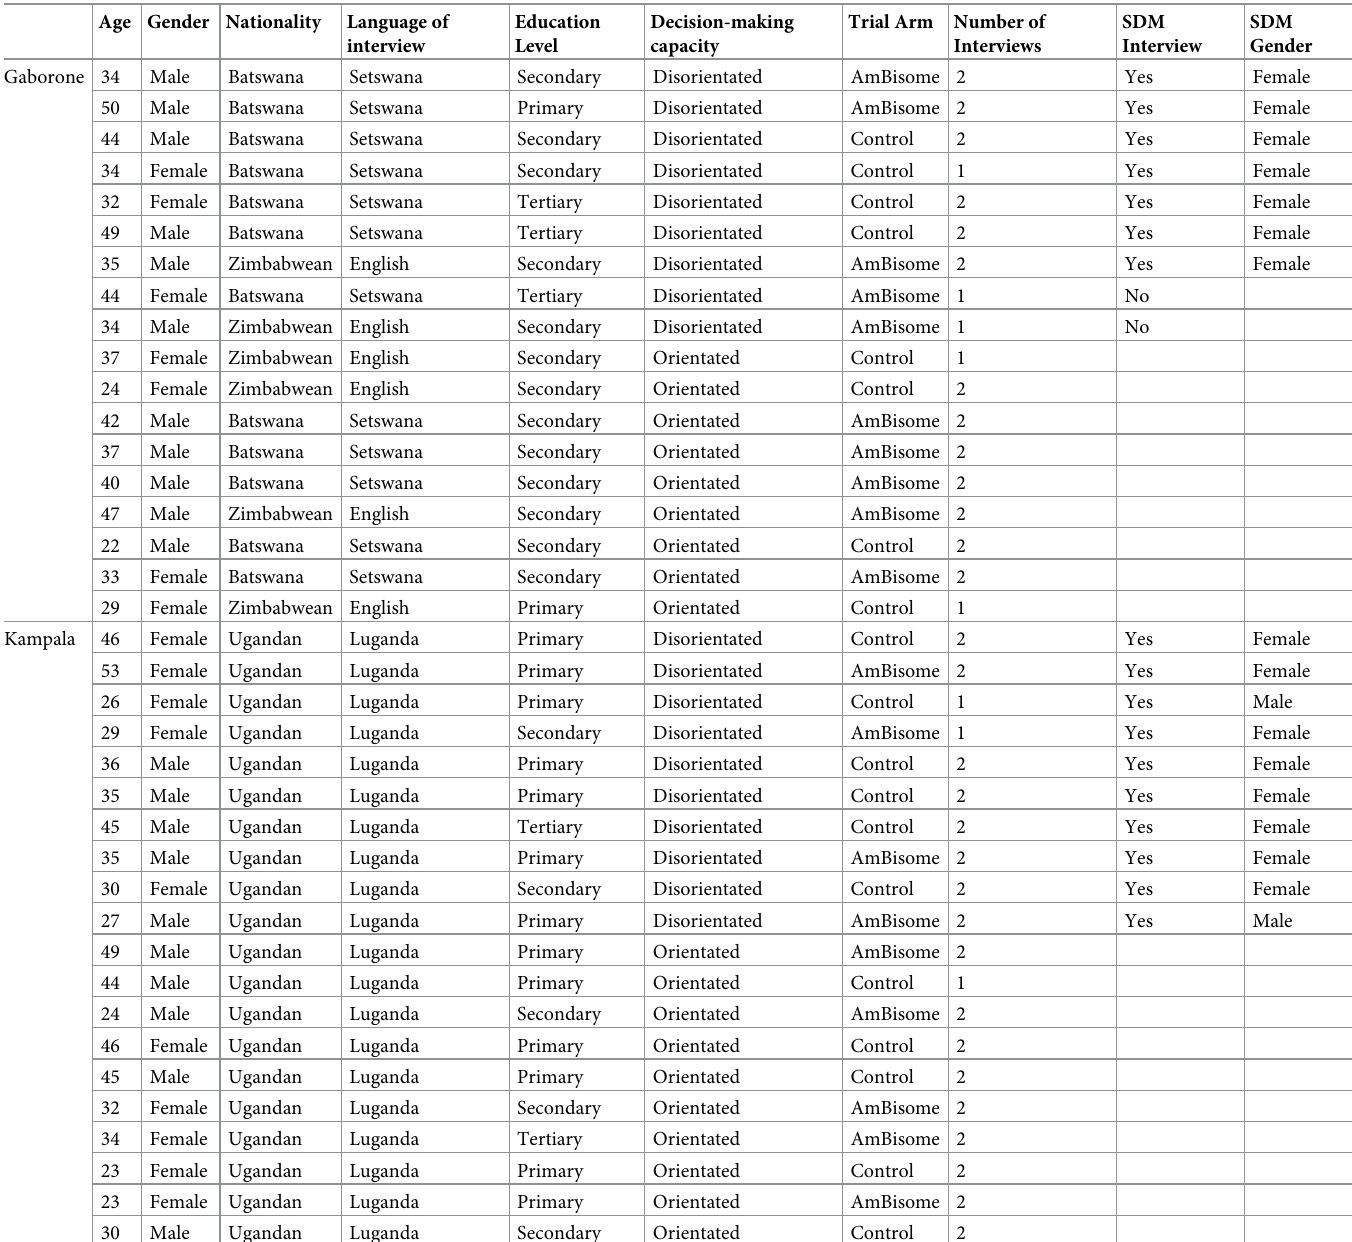
Table 1. Summary of trial participants and surrogate decision makers (SDMs) recruited into the qualitative methods